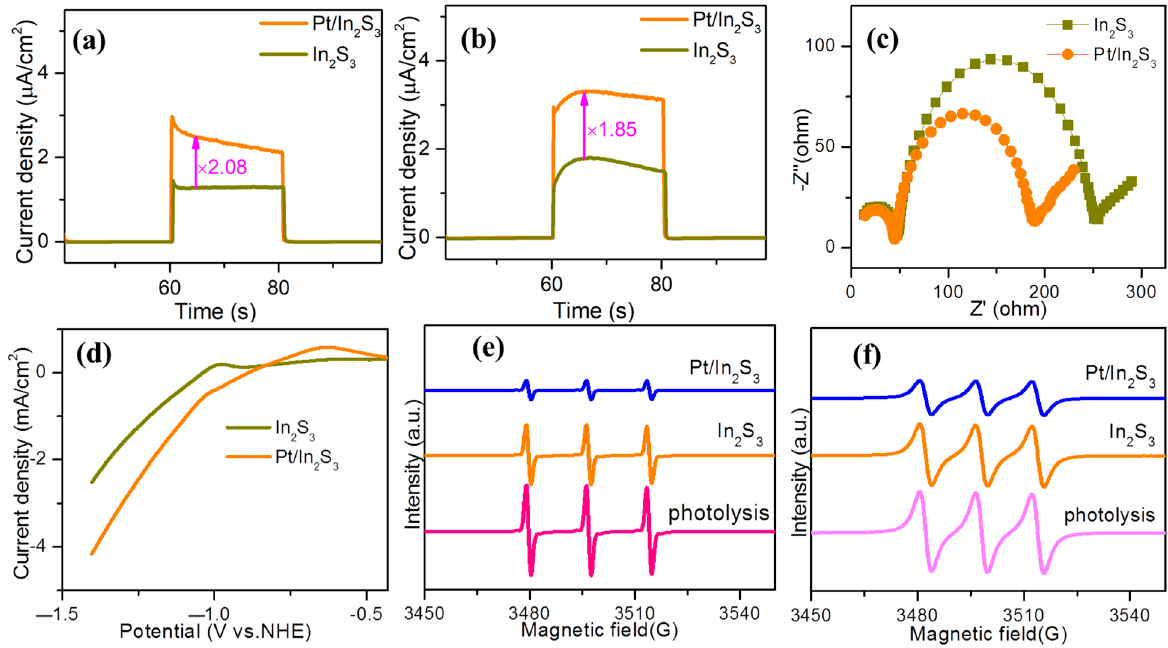
Figure 7. Transient photocurrent responses of catalysts ( a ) without and ( b ) with methyl viologen dichloride (MVCl 2 ). ( c ) EIS plots, ( d ) LSV curves, ( e ) TEMPO-e − EPR spectra and ( f ) TEMPO-h + EPR spectra of In 2 S 3 and Pt/In 2 S 3 .